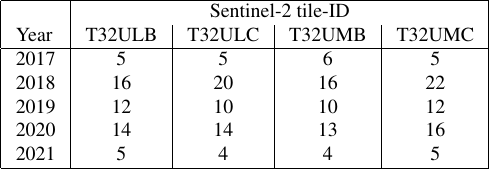
Table 2. Number of images per year and Sentinel-2